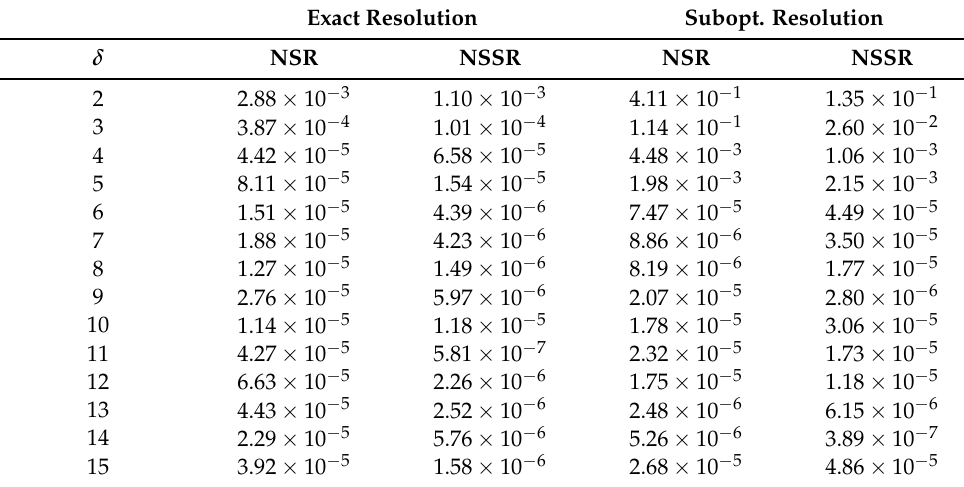
Table 2. p -values for a unilateral Wilcoxon signed-rank test comparing the sample of best NSR (resp. NSSR) for each δ = 2 . . . 15 with δ = 1, for optimal and suboptimal (3 kcal/mol allowed energy gap to real optimum)